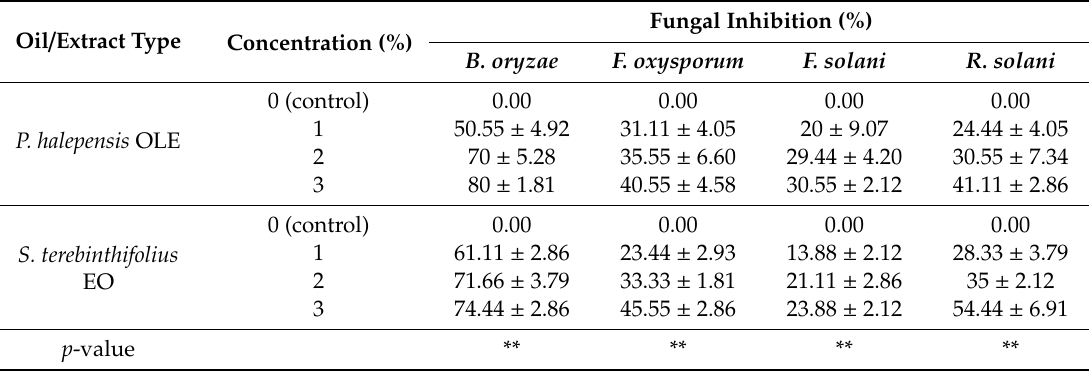
Table 1. Inhibition percentages of fungal growth (%) as a ff ected by wood treated with P. halepensis OLE and S. terebinthifolius